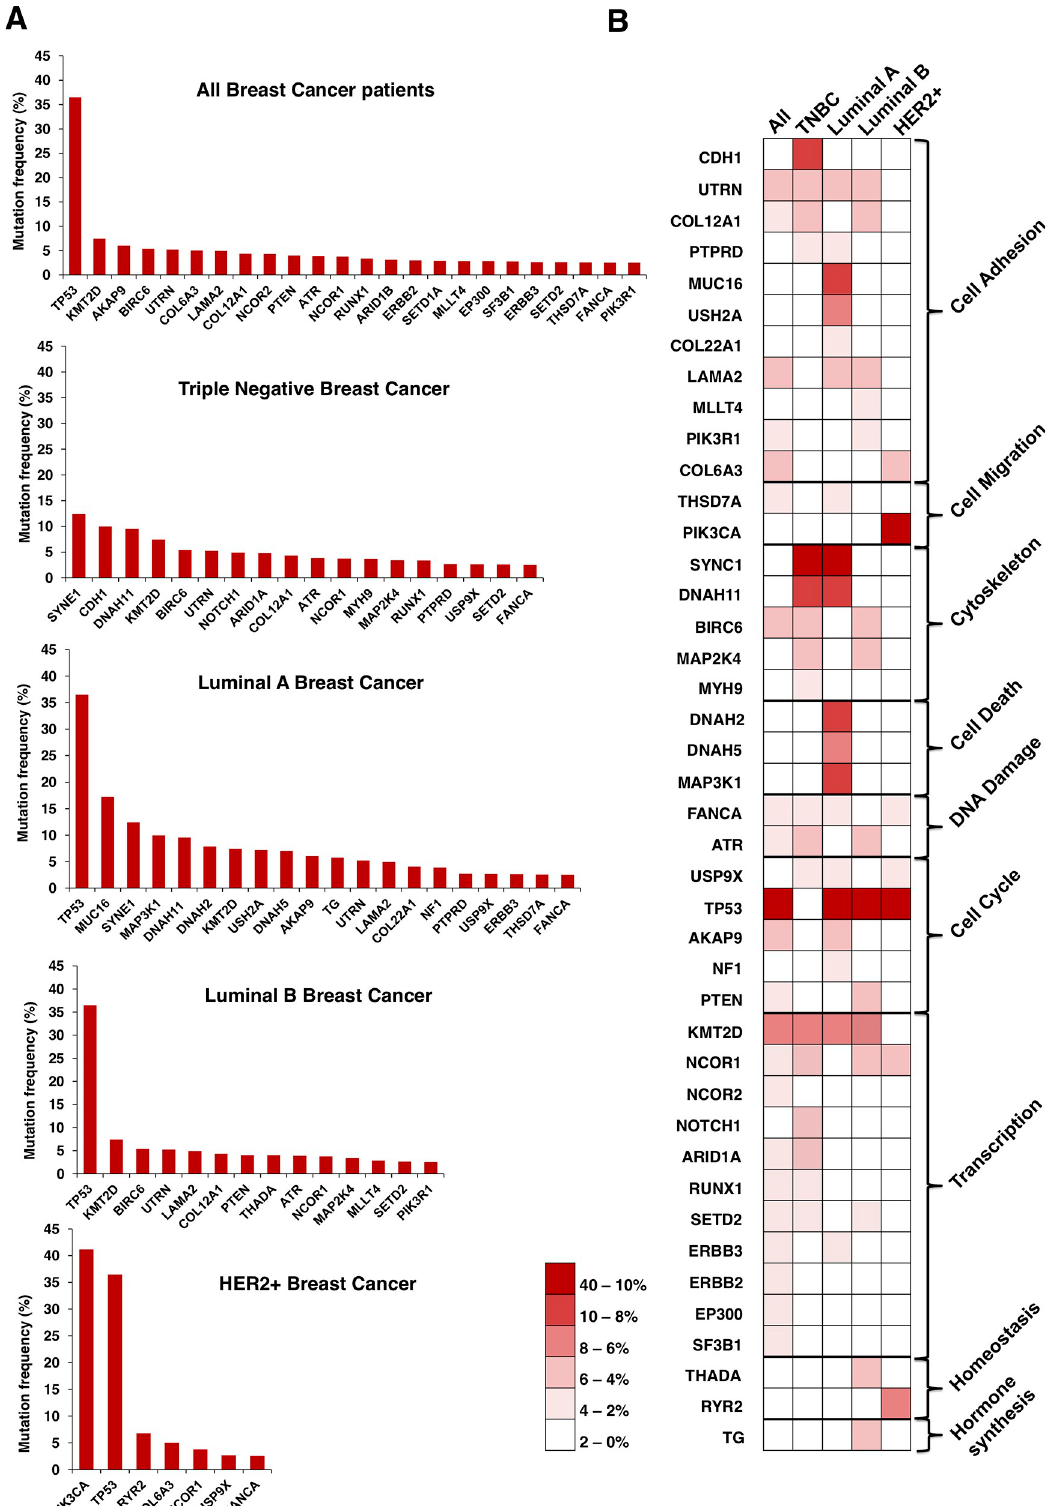
Fig 2. Mutational profile by breast cancer subtype, and association with biological functions. A. Graphs displayed the mutation frequency of those genes mutated in more than 2.5% of patients for all and each breast cancer subtype. B. Heat map of the mutation frequency and the functions of the identified genes for each breast cancer subtypes. The percentage of mutated cases is displayed in the legend. https://doi.org/10.1371/journal.pone.0209134.g002 PLOS ONE | https://doi.org/10.1371/journal.pone.0209134 April 16,